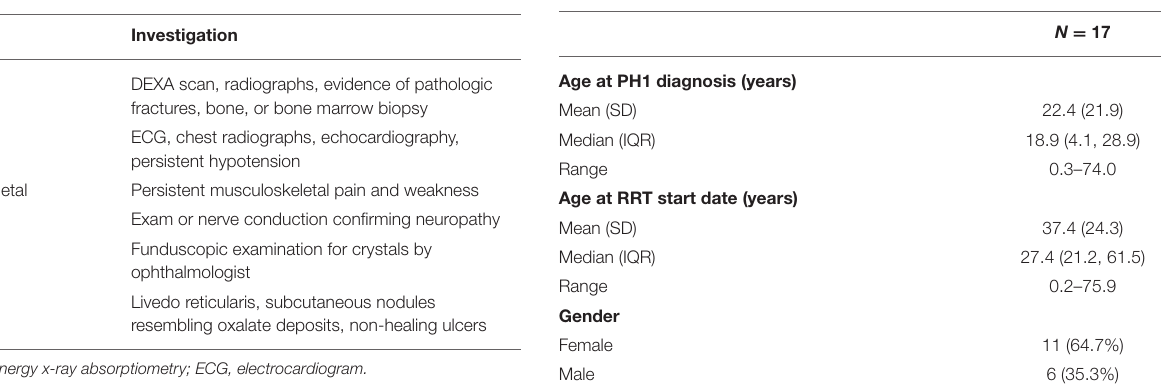
TABLE 2 | Baseline demographic characteristics of PH1 patients at RRT start